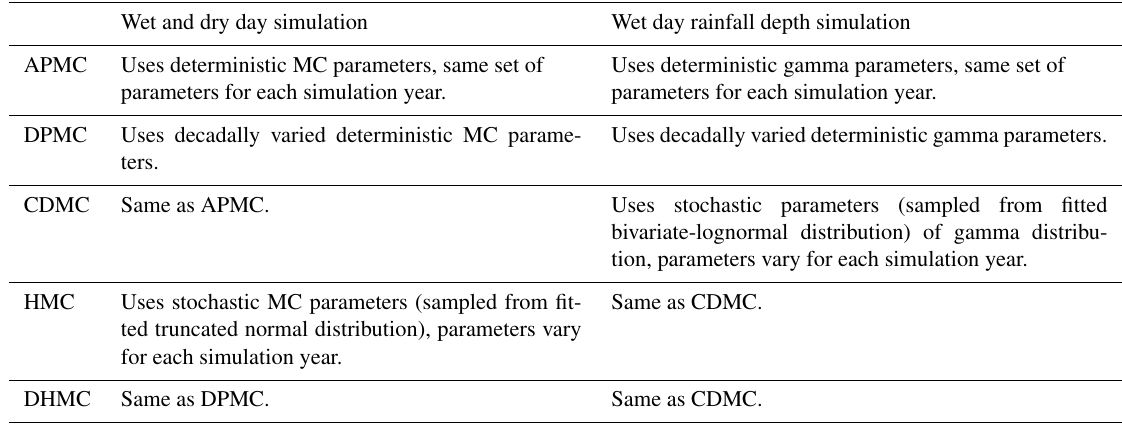
Table 1. Methodological comparison of the five MC models.